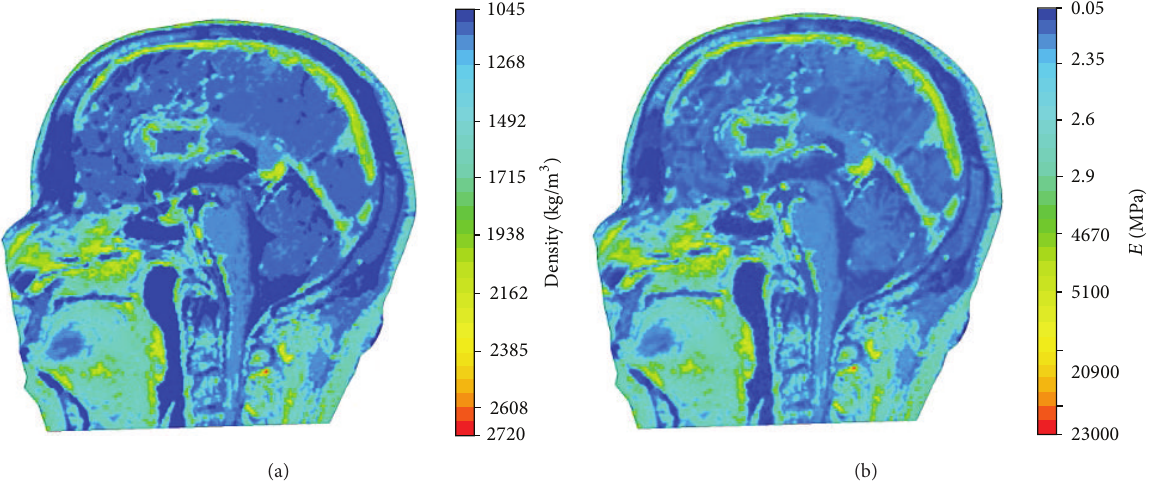
Figure 3: (a) Mass density distribution; (b) Young’s modulus